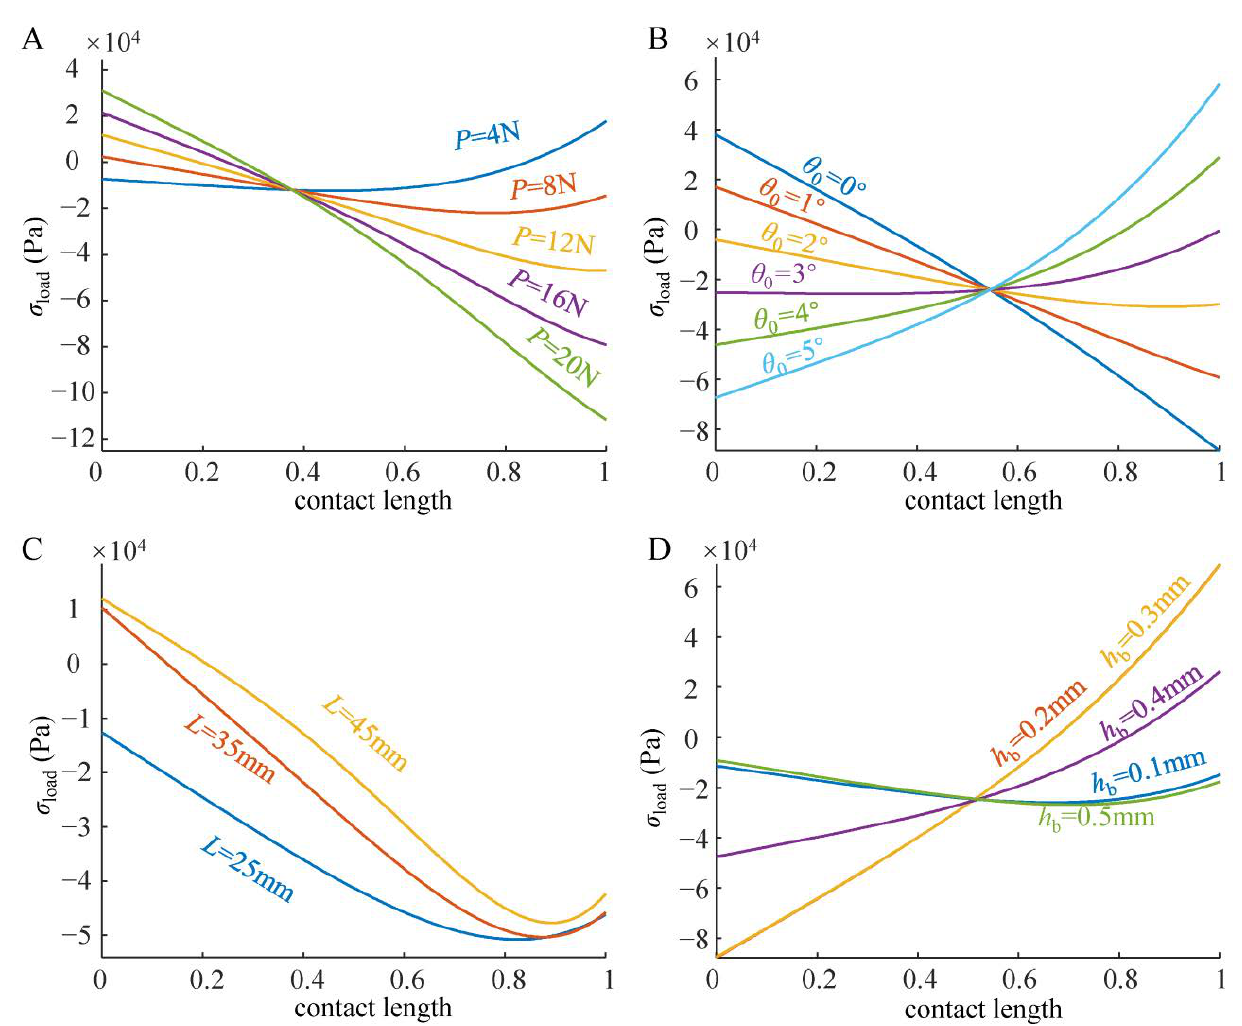
Figure 7. Numerical simulation results of the normal compression strengths at the adhesive interfaces for different ( A ) compression forces P , ( B ) angle of inclination θ 0 , ( C ) unit length L , and ( D ) thickness of RBL h b . The contact length is used as the horizontal coordinate, where a value of 0 for the contact length indicates the position of the free end of the adhesive unit, while a value of 1 for the contact length indicates the position near the solid support end of the adhesive